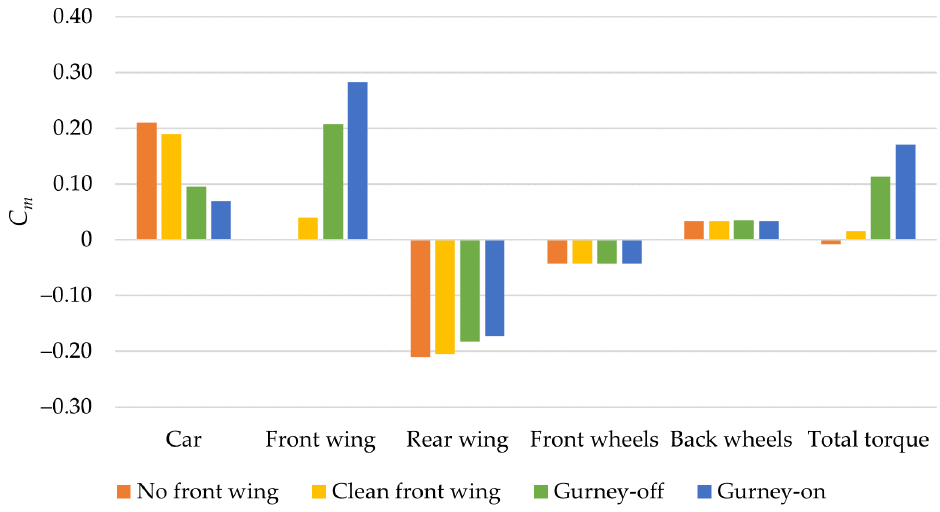
Figure 15. Moment distribution for cases without a front wing and with a front wing.